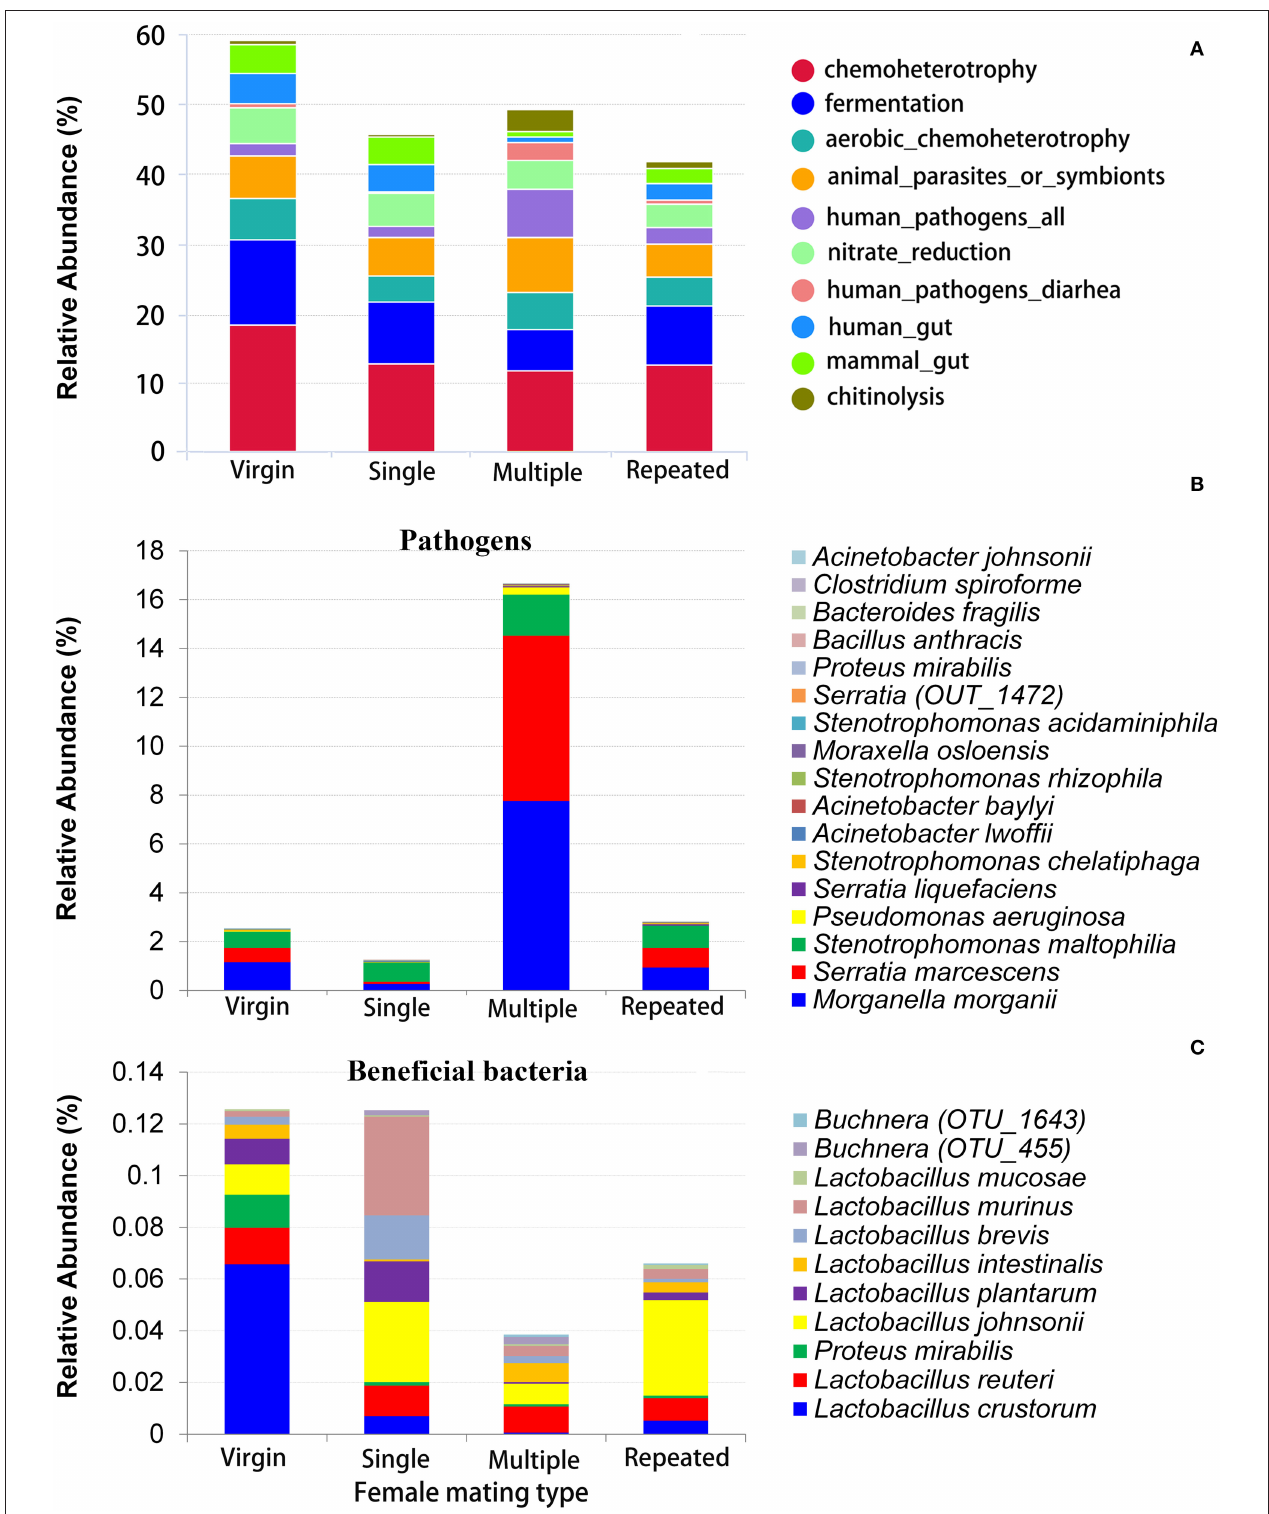
FIGURE 5 | Functional prediction of bacteria in S. frugiperda females of different mating types. (A) The relative abundance of dominate bacterial functional groups (top 10) distribution predicted by FAPROTAX; (B) the relative abundance of possible pathogens; (C) the relative abundance of possible beneficial bacteria (bacteria that are beneficial for their